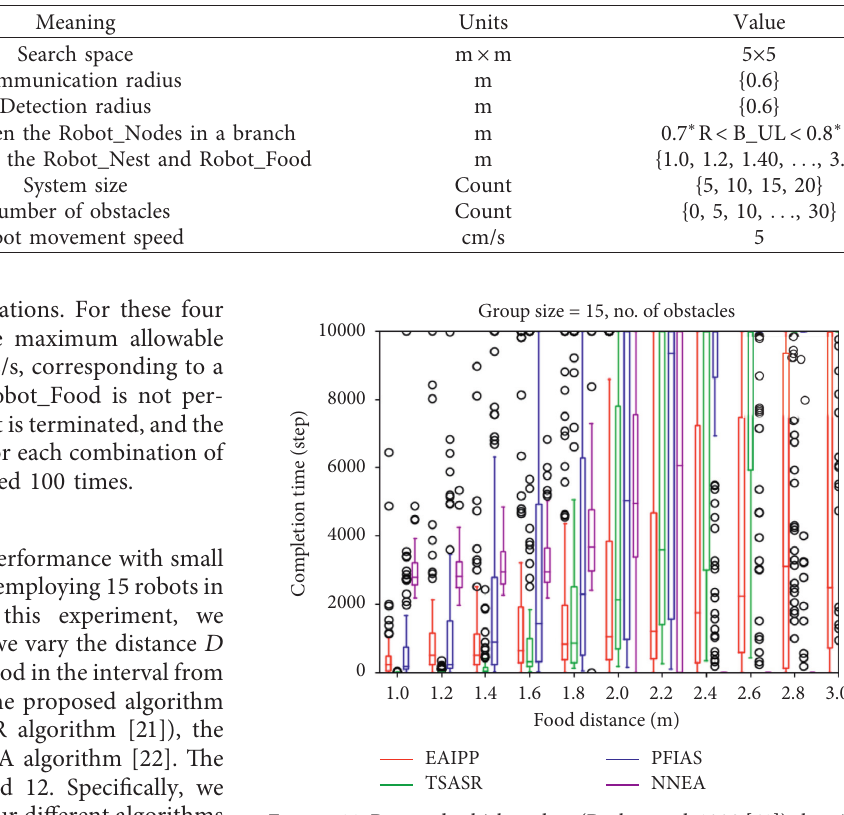
Table 2: Parameter settings for experiments in a square